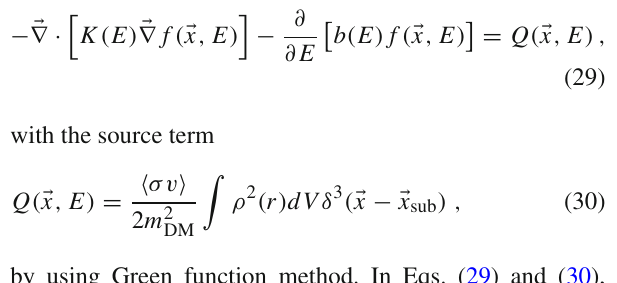
m N = 131 GeV for the target nucleus charge, mass number and mass